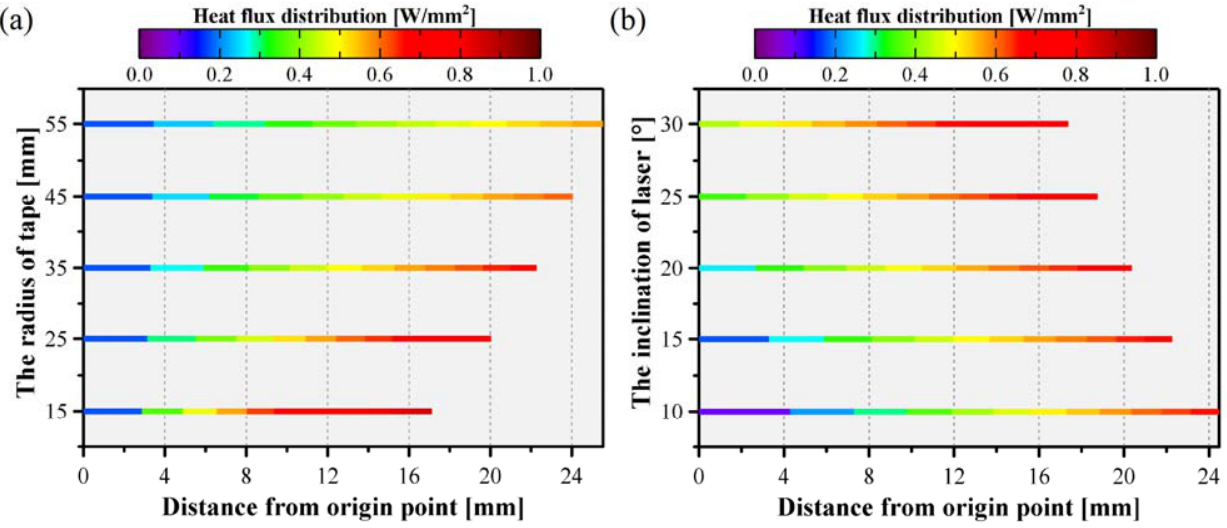
Figure 16. The effect of curvature radius ( a ) and inclination of the laser beam ( b ) on the power density distribution.